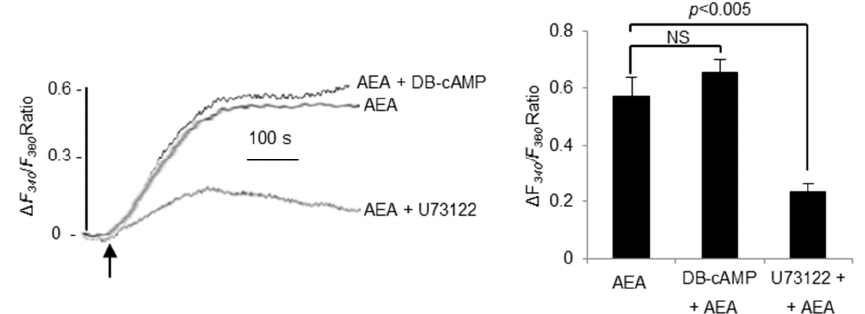
Figure 7. Effects of DB-cAMP and U73122 on anandamide (AEA, 5 µ M)-induced Ca 2+ signaling in TBC. Ca 2+ imaging studies were performed in calcium-containing buffer. The changes in free intracellular Ca 2+ concentrations ( ∆ F 340 / F 380 ) were monitored under the Nikon microscope (TiU) by using S-fluor 40 × oil immersion objectives. Graphs show the increase in [Ca 2+ ] i in taste bud cells freshly isolated from WT mice following addition of anandamide (AEA, 5 µ M) with or without preincubation (20 min) with DB-cAMP (1 mM) or preincubation (20 min) with U73122 (10 µ M) (left panel). The arrowhead indicates when the test molecules were added. Changes as histograms (right panel) in ∆ F 340 / F 380 Ratio induced by anandamide (AEA, 5 µ M) in WT mice TBC after a preincubation with or without DB-cAMP (1 mM) or U73122 (10 µ M). Values are expressed as mean ± SEM ( n =